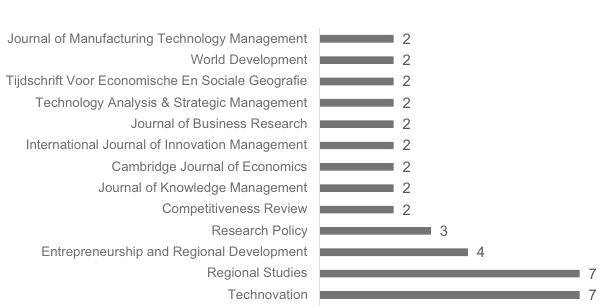
Figure 3. Publications